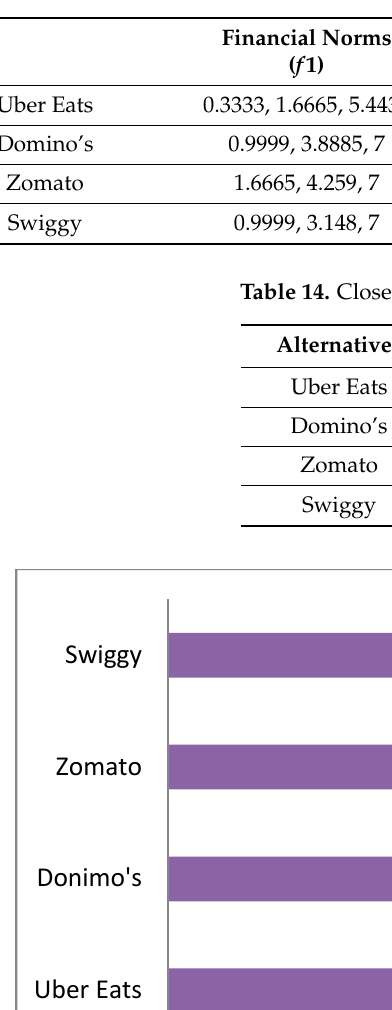
Table 13. Fuzzy weighted normalised decision matrix.